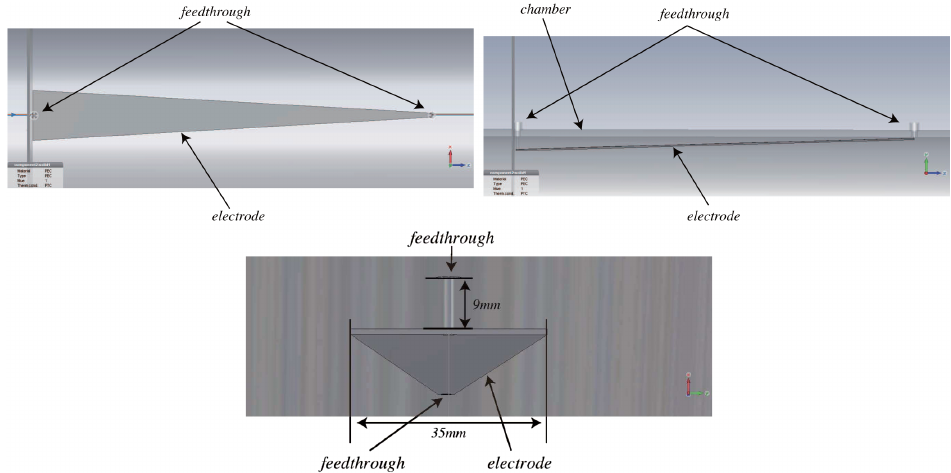
FIG. 6. The simulation model for the triangle electrode. Top view (the upper left), side view (the upper right) and front view (the lower) of the